Question: State the chart type depicted above.
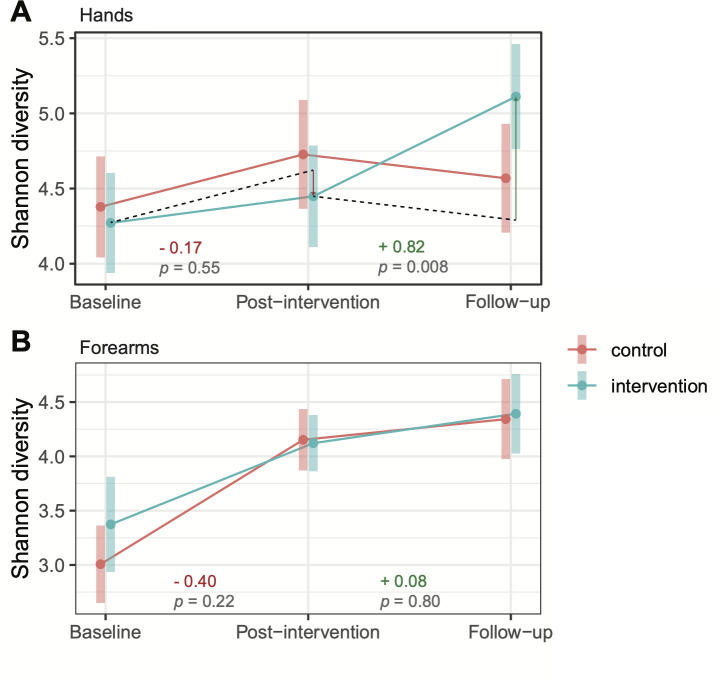
Answer: bar